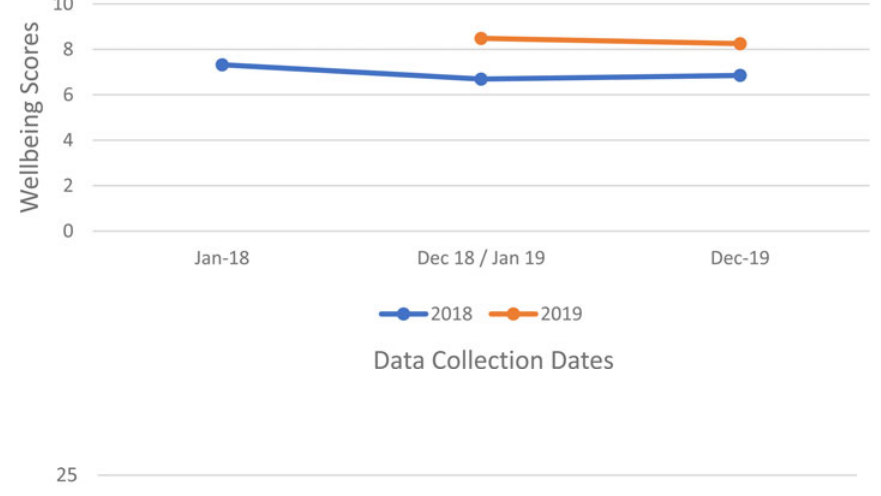
Fig. 3. Wellbeing Mean Scores for 2018 & 2019 Cohorts